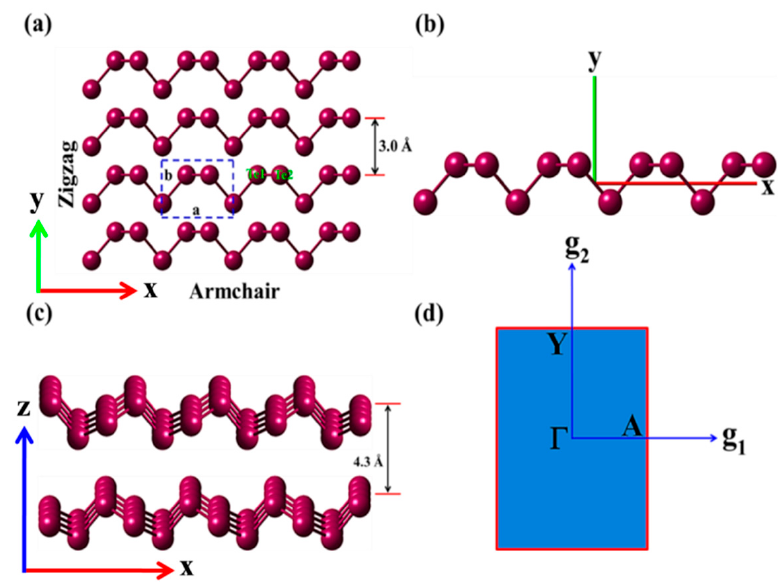
Figure 1. Structural model of trigonal crystal of 2D-Tellurene. ( a ) top view of Tellerene showing armchair and zigzag orientations and the enclosed section with dotted line shows the unit cell with four-sided dimensions; ( b ) single helical chain of 2D-Tellurene growing along the x -direction [100]; ( c ) two-layer chiral-helical-chains vdW structure; ( d ) the first Brillouin zone of the conventional unit cell of 2D-Te in all calculations of the monolayer and few-layer of Tellurene.